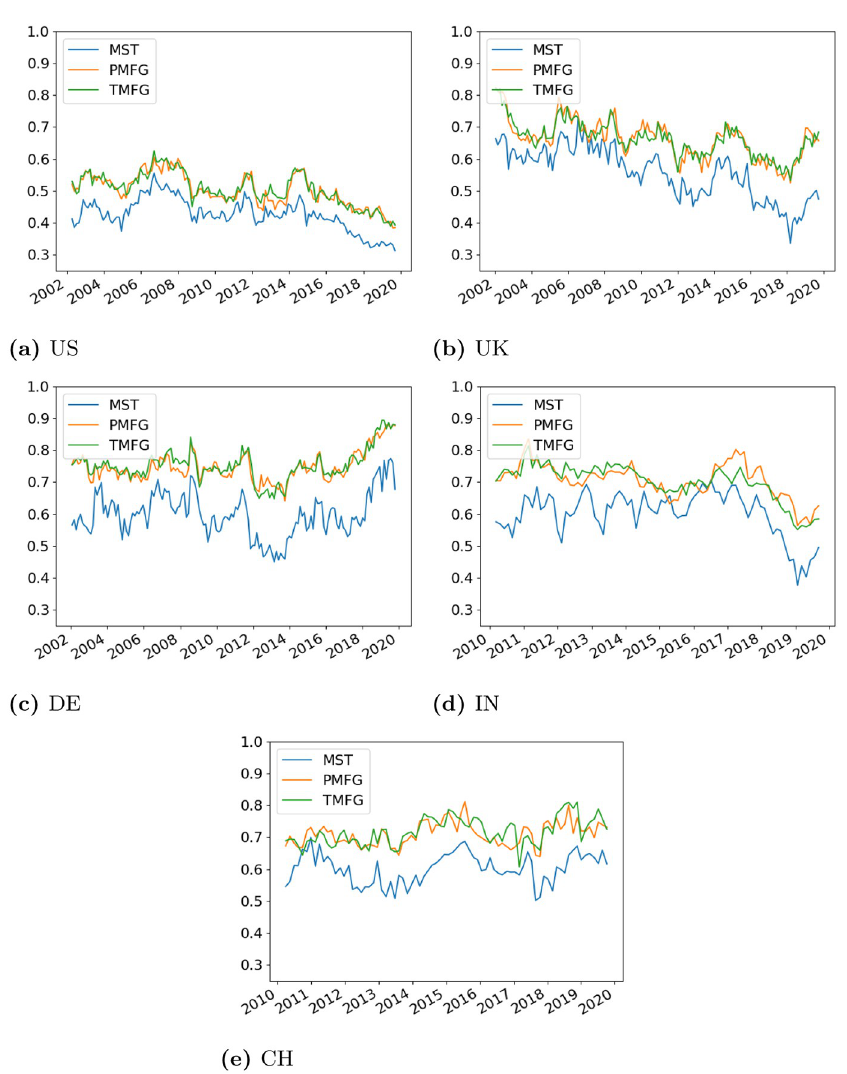
Fig 8. Correlation between degree centrality in the full and filtered networks over the dataset. (a) US, (b) UK, (c) DE, (d) IN, (e) CH.